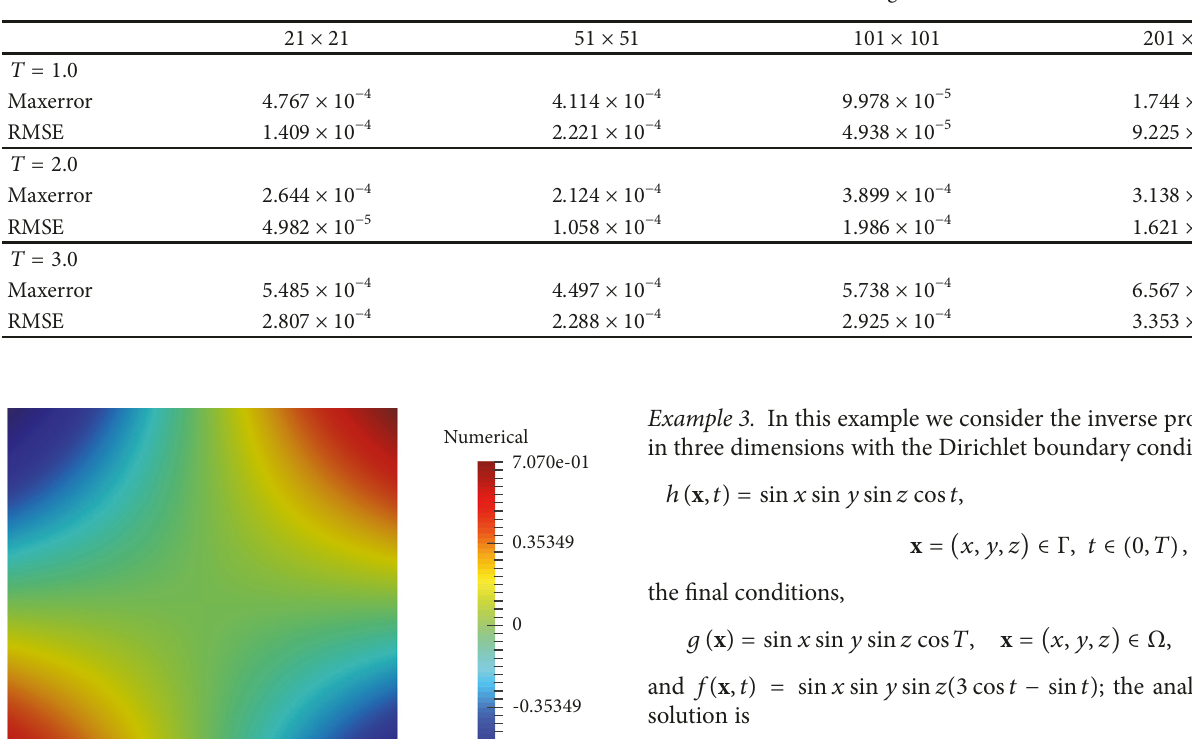
Table 4: Maxerror and RMSE for 𝑇 = 1.0,2.0,3.0 with different grids.